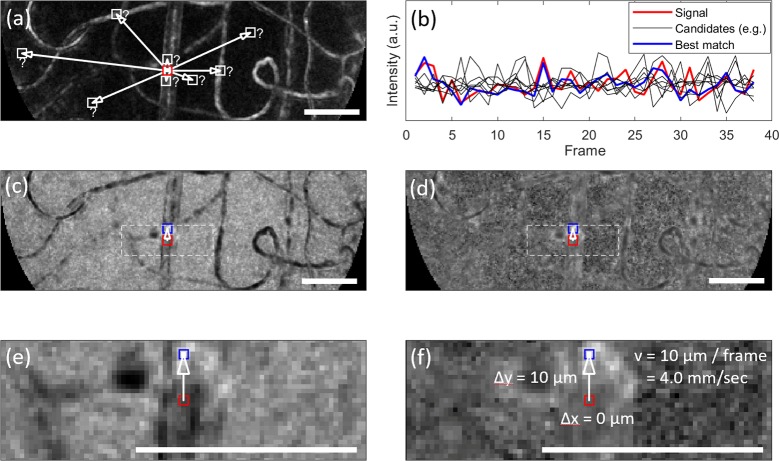
Illustration of velocity calculation for a single pixel.a) Shows the motion contrast image during a 100 ms epoch. The reference pixel whose velocity is to be determined is shown in red. All available image pixels are assayed to determine the best match (white boxes show example candidates); b) shows intensity over time for the reference pixel (red), for the pixel producing the best match after shifting forwards by one frame (blue), and for the other example pixels that were indicated in (a) (black); c) shows the similarity image for the reference pixel (red), which is populated by calculation of root-mean-square (RMS) error between the reference signal and all considered image pixels after shifting by one frame. The brightest pixel (blue) indicates the best match; d) as per (c), but image has been “normalized” by subtracting the standard deviation, which enhances the amplitude of the peak relative to the background; e) as per c), but zoomed according to dashed box shown in (c) for improved visualization; f) as per e), but zoom has been applied to d). The calculation of velocity for this example is overlaid on the image. Scale bars show 50 μm.